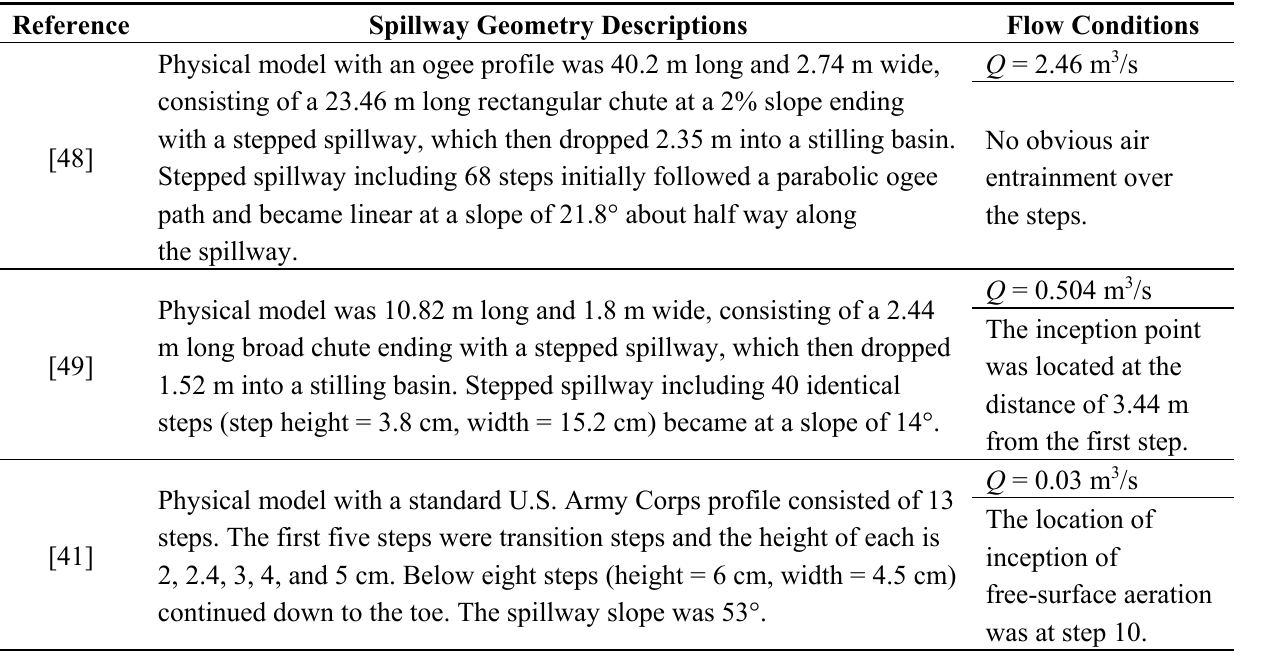
Table 1. Experimental investigations of skimming flow over stepped